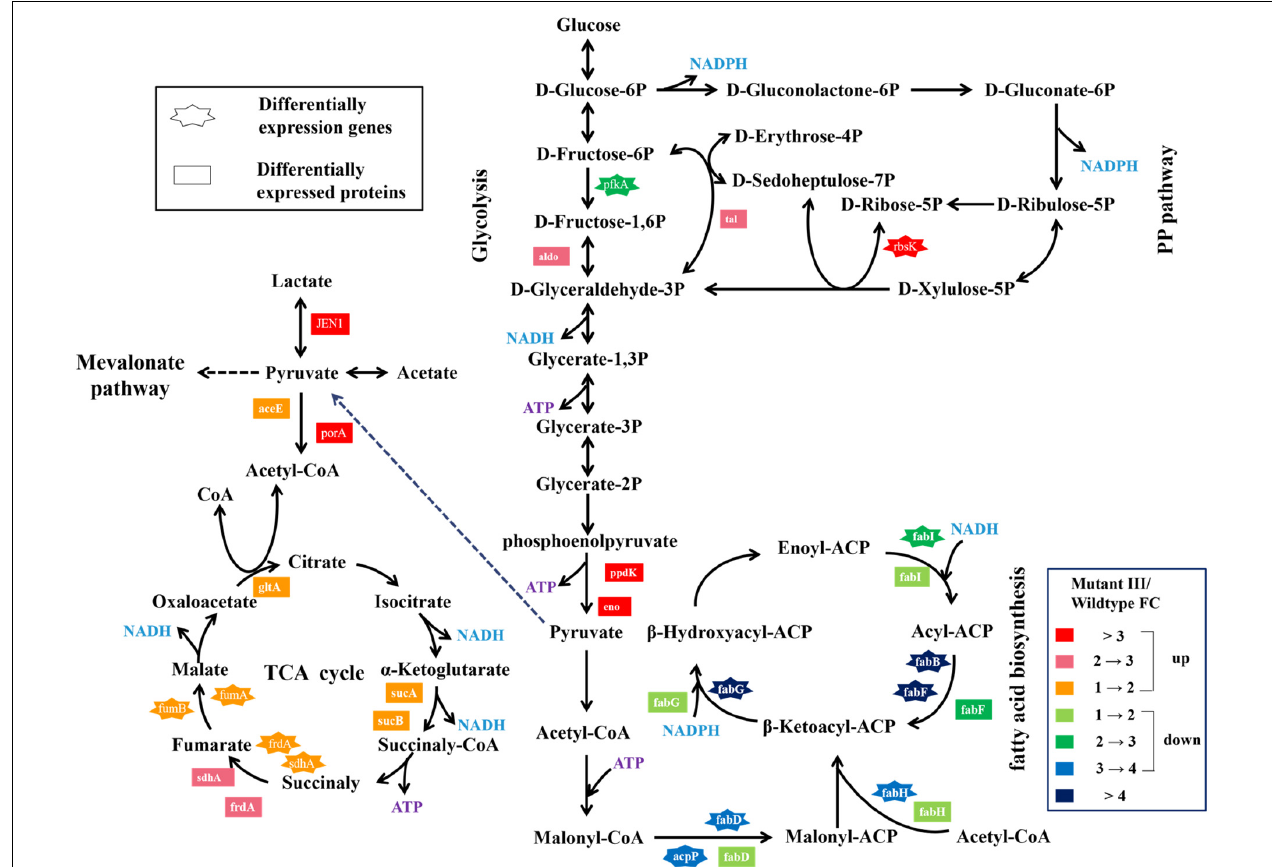
FIGURE 3 | Changes of expression level of genes and proteins involved in the pyruvate metabolism and the PP pathway in P. acidipropionici after combined metabolic and evolutionary engineering.